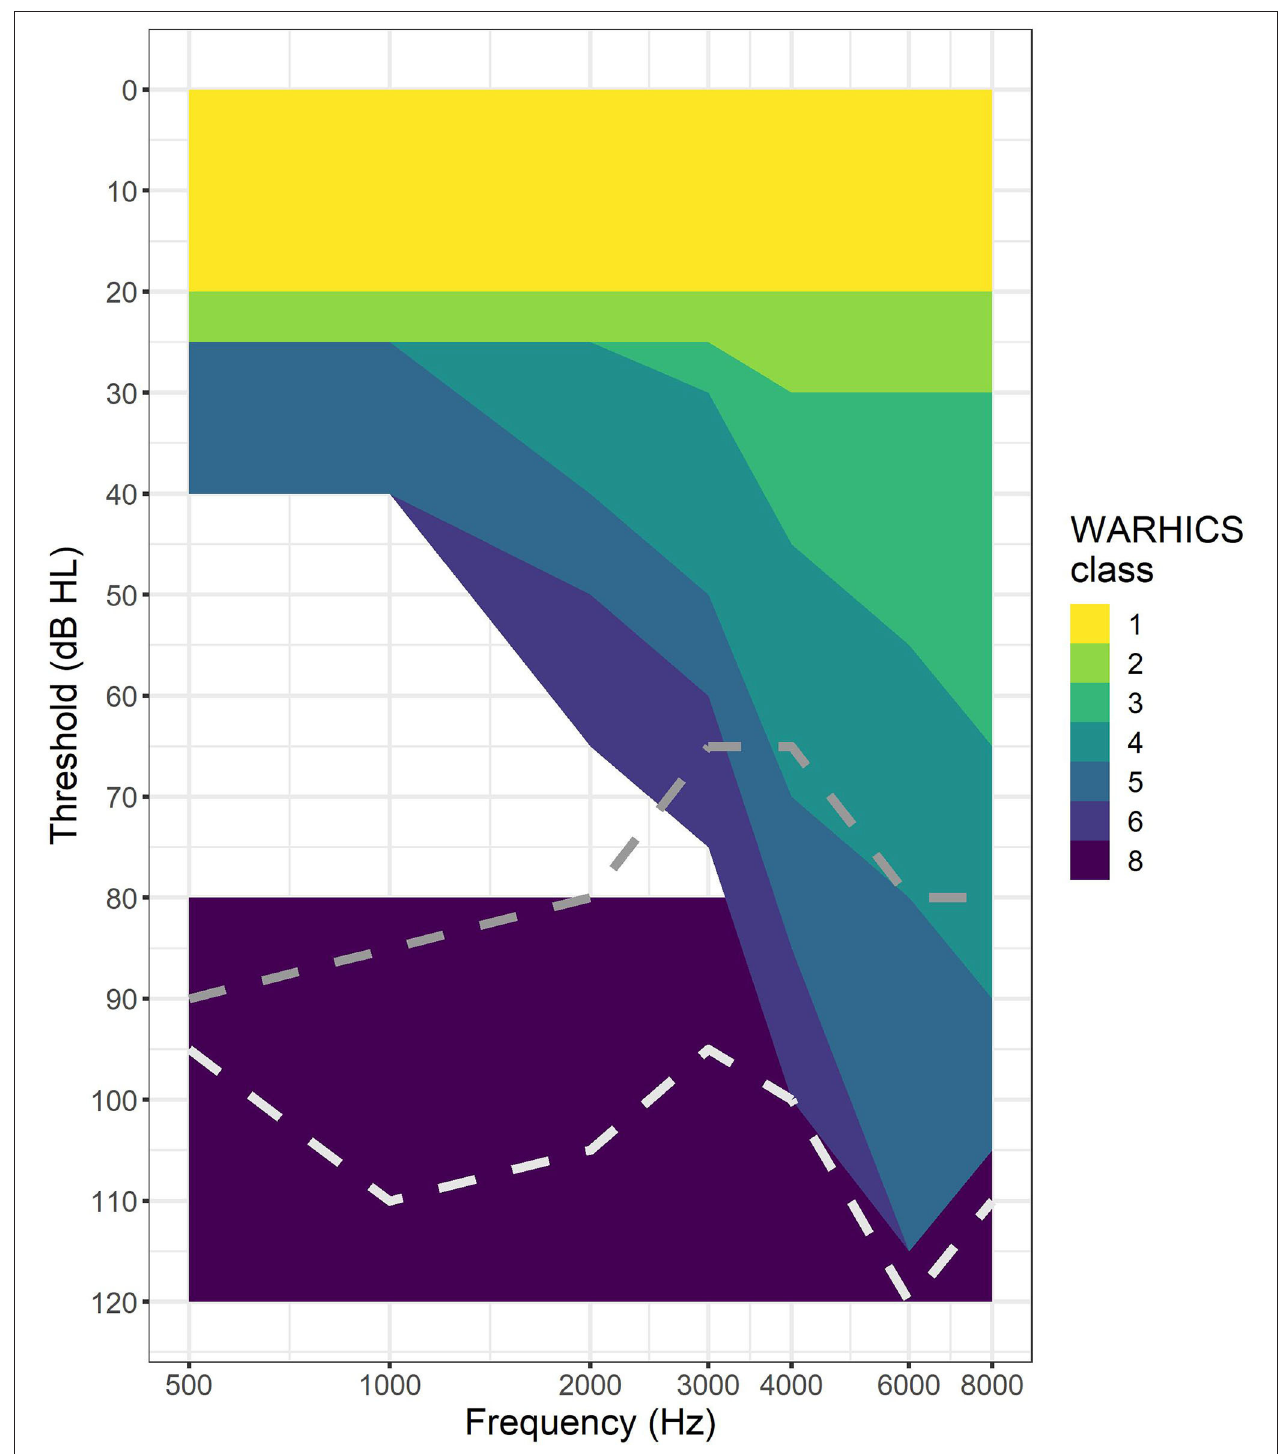
FIGURE 1 | WARHICS classes plotted on an audiogram. Shaded regions represent regions in which an individual’s audio must fall to be classified as that WARHICS class. Gray dotted line is an example from WARHICS class 7 (not 1–6 and at least one threshold < = 80 dB). White dotted line is an example from WARCHIS class 8 (all thresholds > = 80